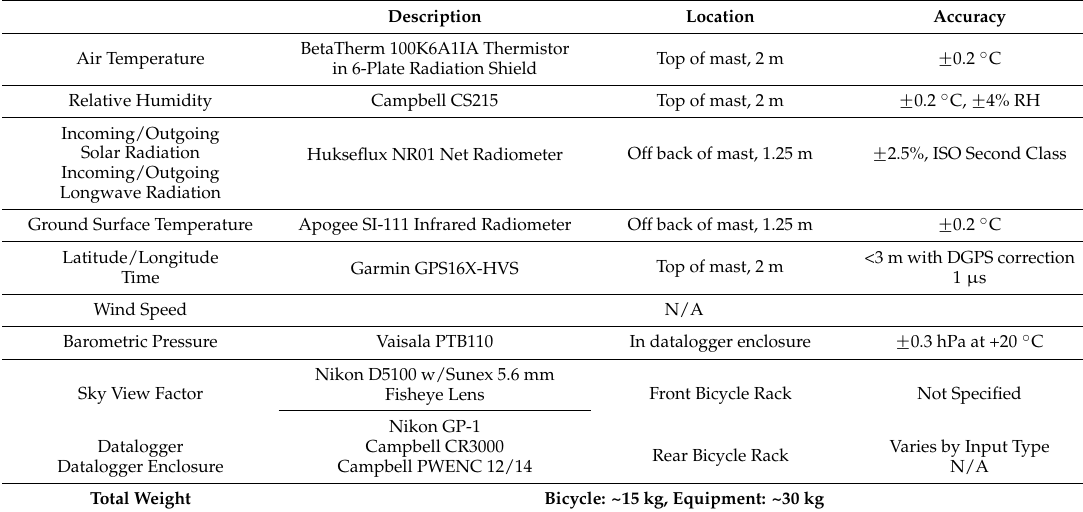
Table 1. Equipment installed on the mobile measurement